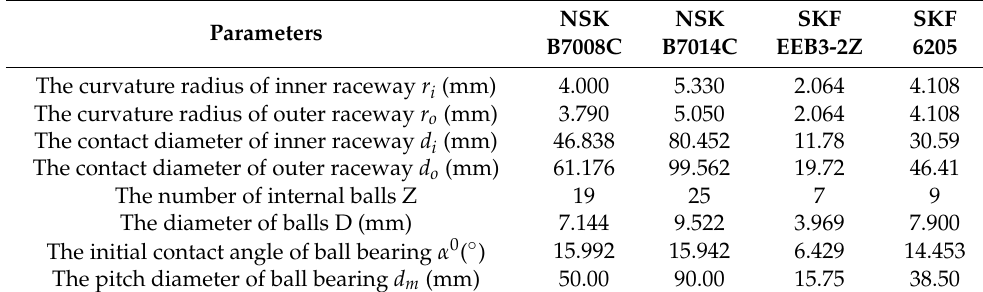
Table 1. T Bearing parameters of NSK B7008C, B7014C, and SKF EEB3-2Z.